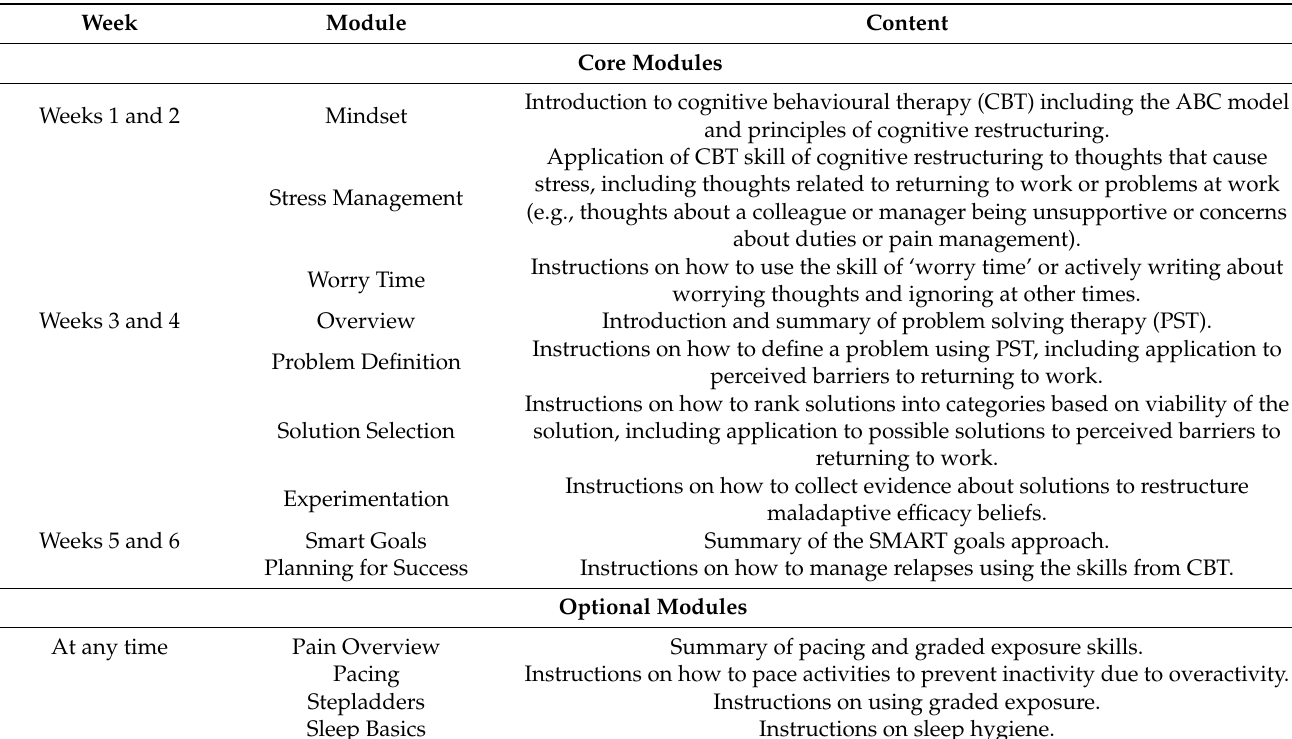
Table 1. Content of the Web-based Workable